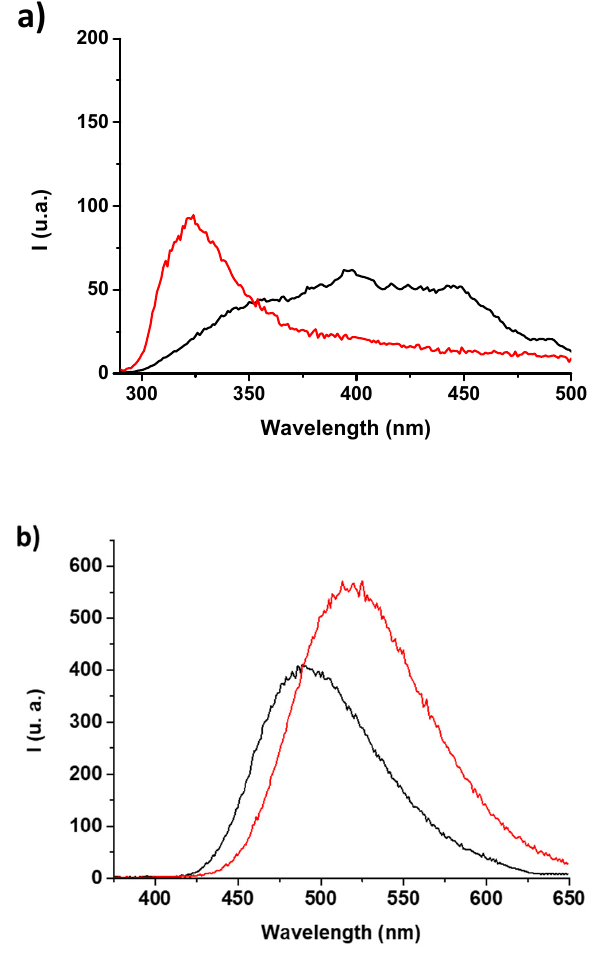
Figure 7. Fluorescence spectra of ( a ) L1 (2.5 × 10 − 5 M, λ ex = 278 nm) in DMSO solution (red curve) and in gel phase in DMSO/H 2 O (H 2 O 15% v / v ) (black curve) and ( b ) L2 (2.5 × 10 − 5 M, λ ex = 342 nm) in DMSO solution (red curve) and in gel phase in chlorobenzene (black curve).